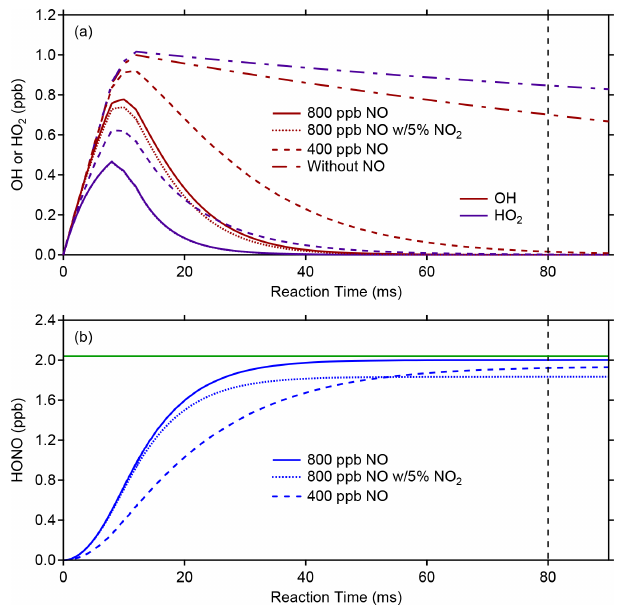
Figure 5. Photolysis efficiency (PE) calibration modeling. The top plot illustrates the modeled evolution of OH (red lines) or HO 2 (blue lines) in the presence of 400 (dashed line) or 800ppb (solid line) of NO, while the bottom plot shows the modeled HONO production (blue lines). The vertical black dashed line represents the approx- imate reaction time between the onset of radical production from 184.9nm photolysis of water and the exit of the calibration source at a flow rate of 10SLPM. The horizontal green line represents the total radicals produced in the photolysis region in the absence of NO. The dotted line represents a simulation with 800ppb of NO with a 5% NO 2 impurity (see text).